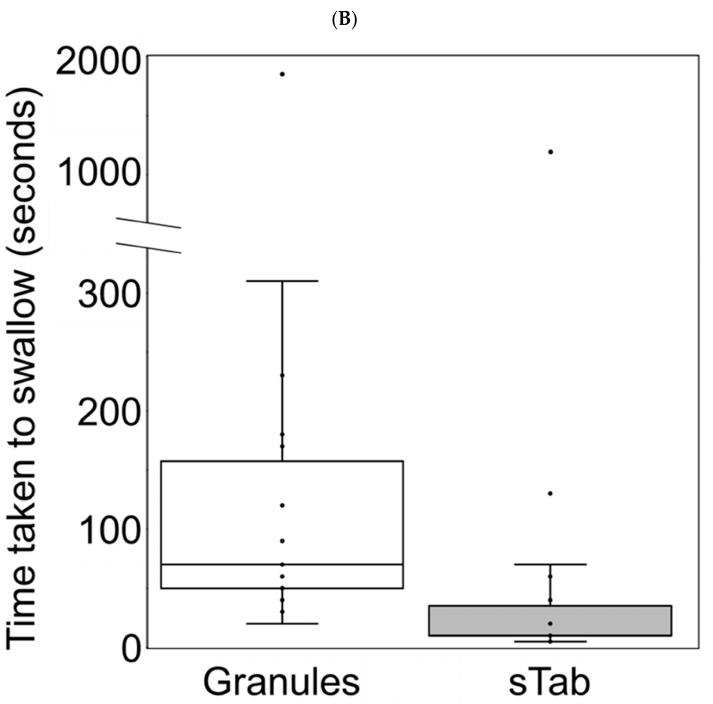
Figure 3. Time taken to administration the Sulfamethoxazole trimethoprim combinations. Each plot showed the administration time for each case. The center line indicated the median, boxes indicated first and third quartile range (IQR), whiskers indicated upper or lower fence, and plots outside the fence indicated outliers (1.5 × IQR). White boxes indicate administration times for conventional tablets ( A ) or granules ( B ); black boxes indicated administration times for small tablets ( A , B ). sTab, small